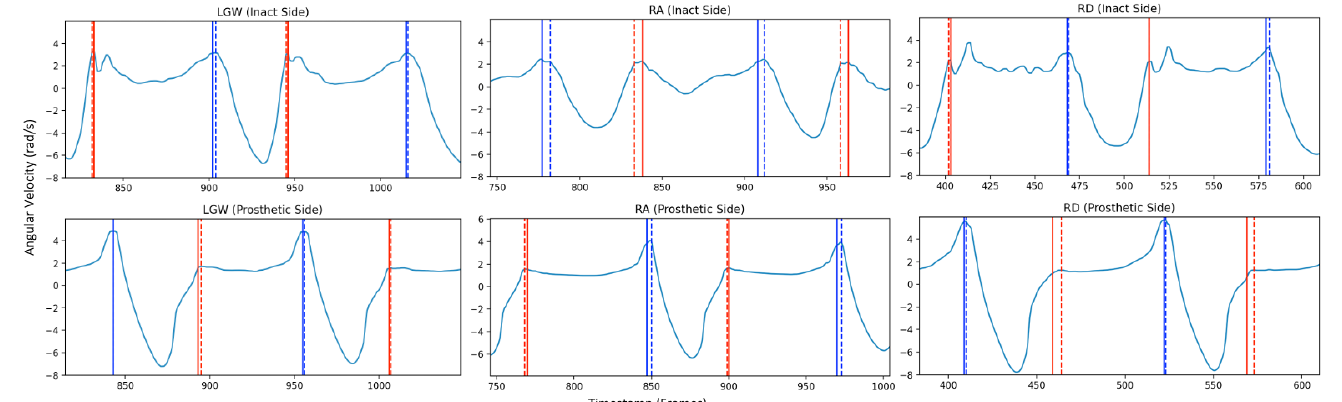
Figure 3. Sample data displaying GED events detected (FS and FO) for LGW, RA, and RD of both intact and prosthetic sides of LLPU_P02 (transfemoral). Plot of raw angular velocity signal (light blue). FS (blue) and FO (red), Xsens (solid) and proposed algorithm (dashed). Table 2. Overall sensitivity (mean (standard deviation)) results of GED algorithm.